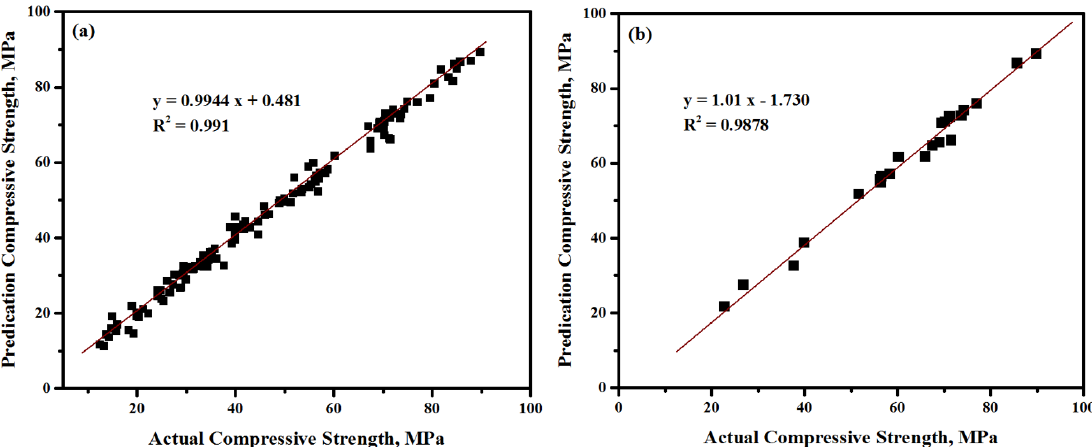
Figure 13. Predicted and measured CS correlation of the proposed LWCs for the ( a ) training and ( b ) testing data. Table 6. The comparison between the experimental data for the testing set and the predicted results from the ANN model. Experimental